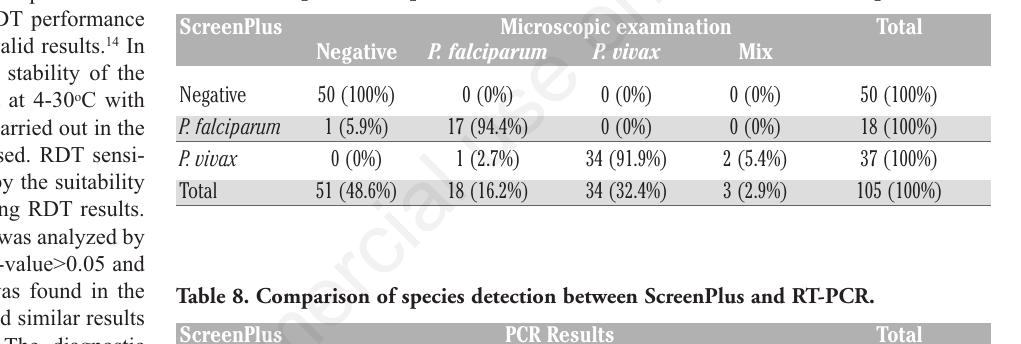
Table 7. Comparison of species detection between ScreenPlus and microscopic results.